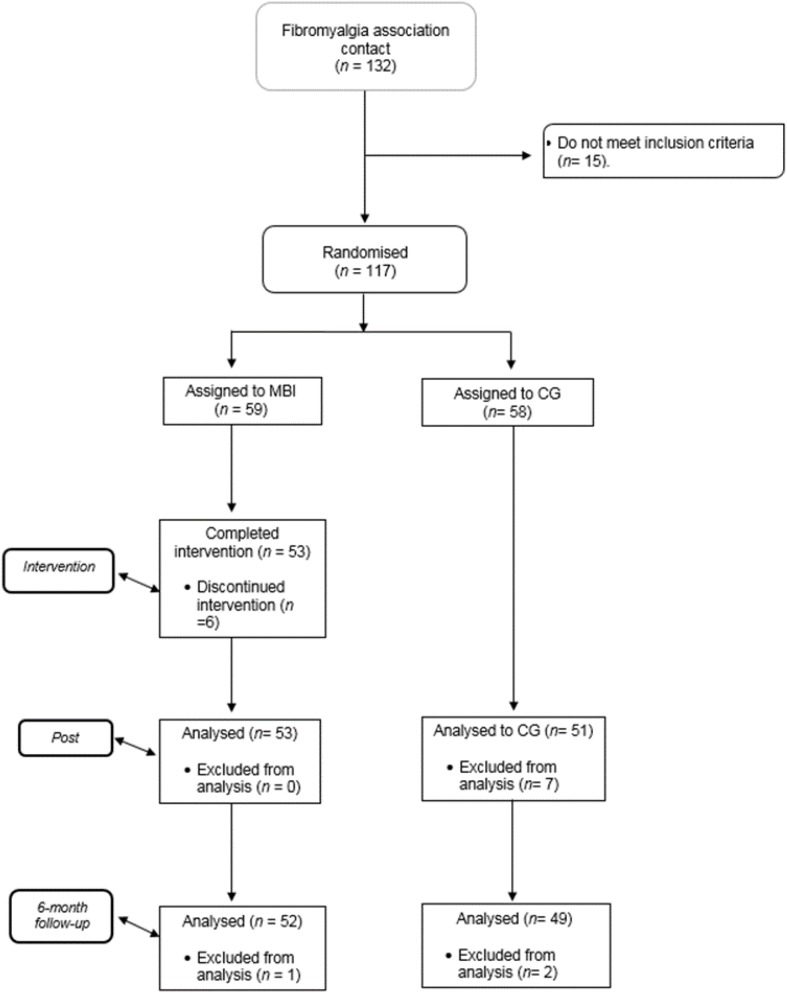
Participant flow diagram. MBI mindfulness-based cognitive therapy (EG), treatment as usual control group condition (CG).